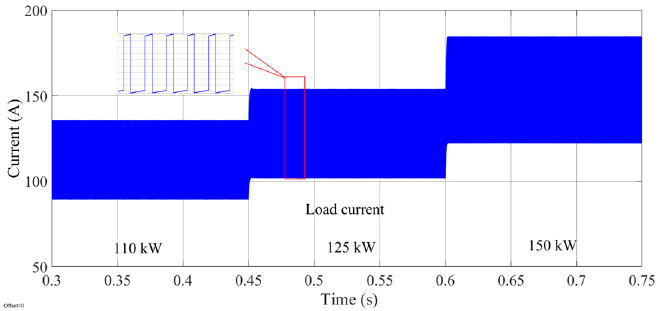
Figure 9. Load current i load demanded by Z load Figure 9. Load current 𝑖 (cid:3039)(cid:3042)(cid:3028)(cid:3031) demanded by 𝑍 (cid:3039)(cid:3042)(cid:3028)(cid:3031) .